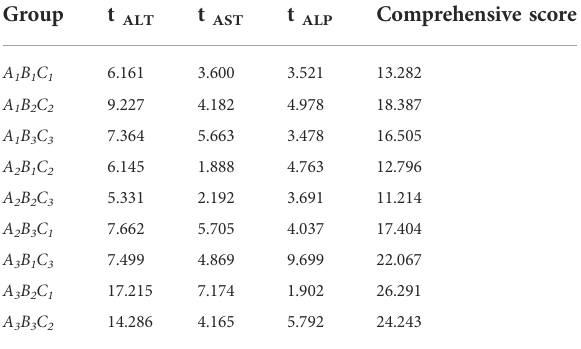
TABLE 4 The results of serum T value of each group of mice of ASR- processed RDB. Group t ALT t ALP Comprehensive